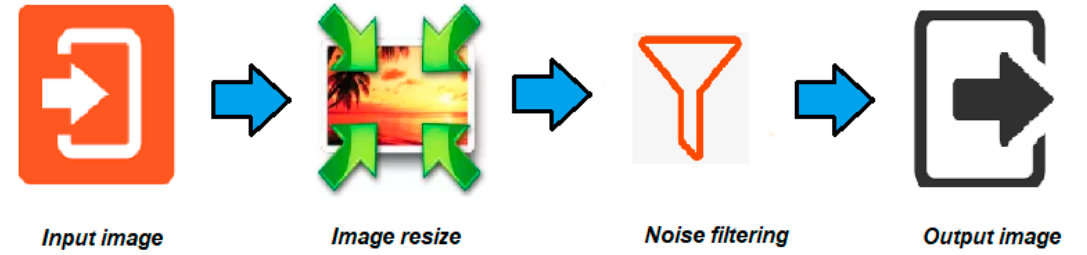
Figure 2. Data preprocessing steps.